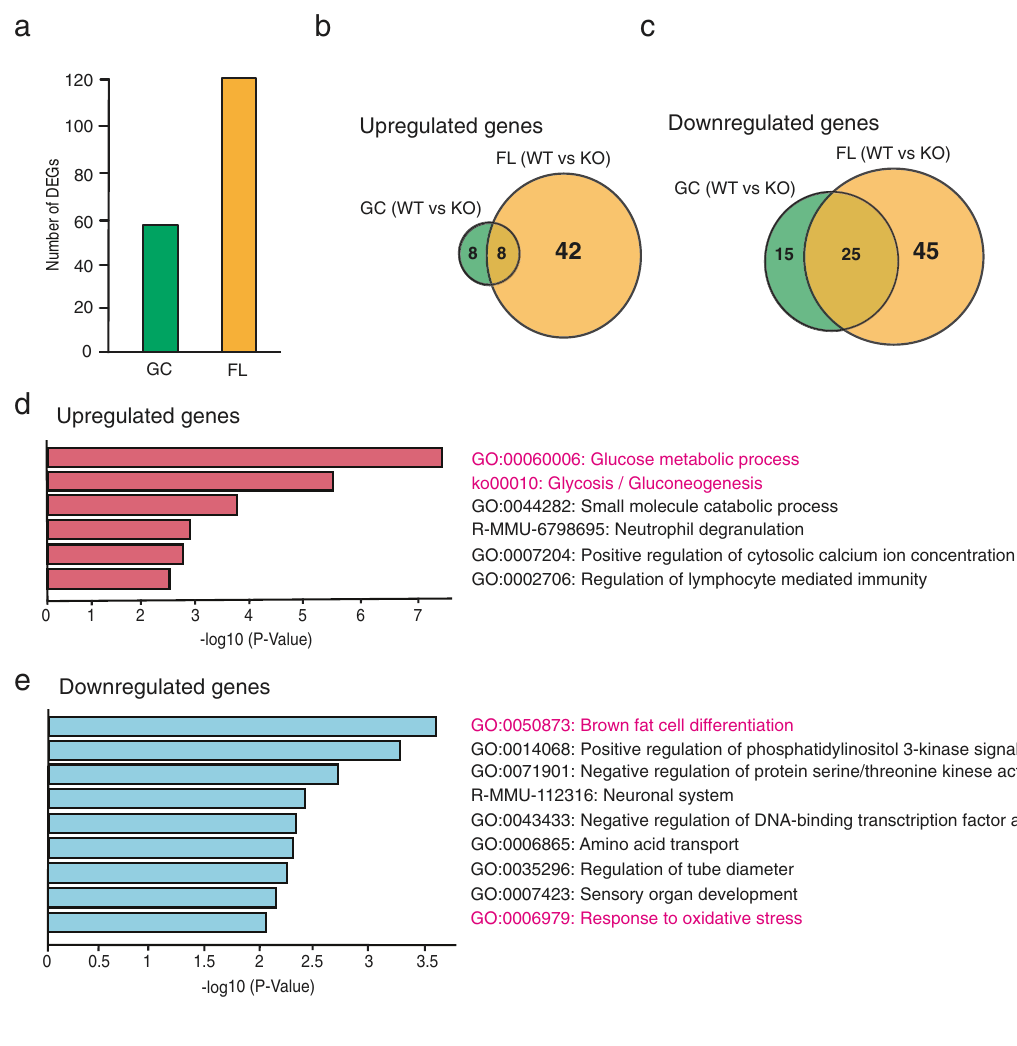
Fig. 6 Enrichment analysis of differentially expressed genes between WT and KO mice. a The number of DEGs identi fi ed in GC (WT vs. KO) and FL (WT vs. KO) mice. Venn diagram depicting the comparison of upregulated genes ( b ) or downregulated genes ( c ) in WT vs. KO mice under GC and FL conditions. Enrichment analysis of KO-FL-speci fi c DEGs including 42 upregulated genes ( d ), and 45 downregulated genes ( e